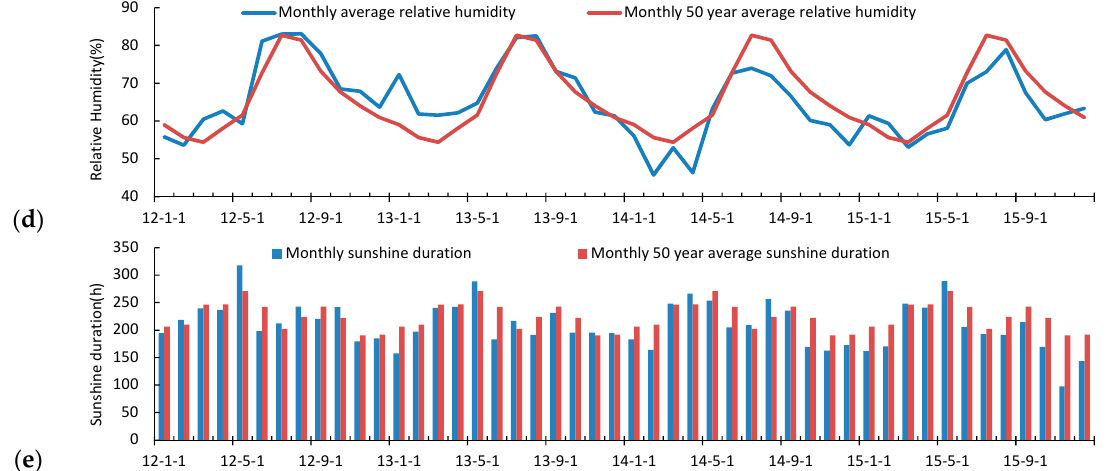
Figure 4. Comparison of the meteorological elements with the 50-year average (1960–2010). ( a ) Temperature; ( b ) Precipitation; ( c ) Wind speed; ( d ) Relative humidity; ( e ) Sunshine duration. Table 3. Meteorological factors and 50-year average comparison for 2012–2015.